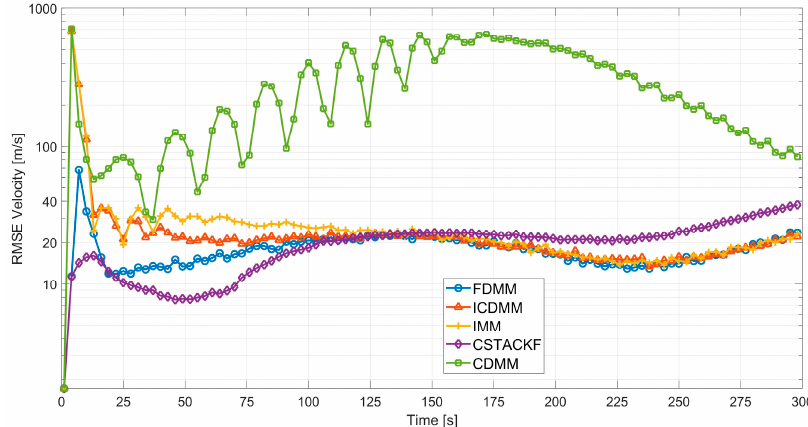
Figure 7. The comparison of velocity RMSE for different algorithms in Case 1.